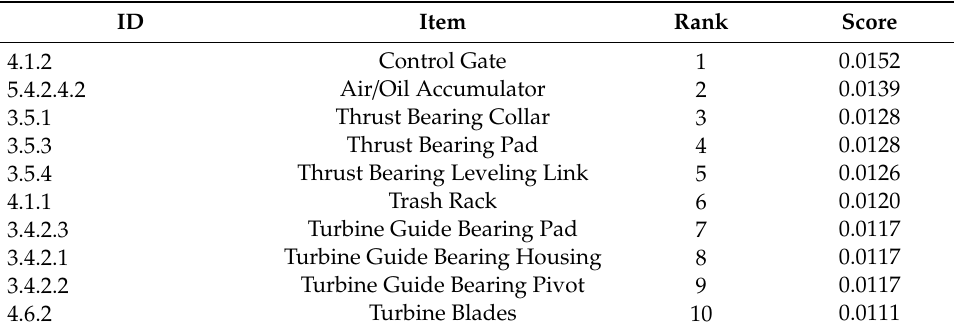
Table 11. Item Classification Matrix with the Top Ten Maintenance Significant Items